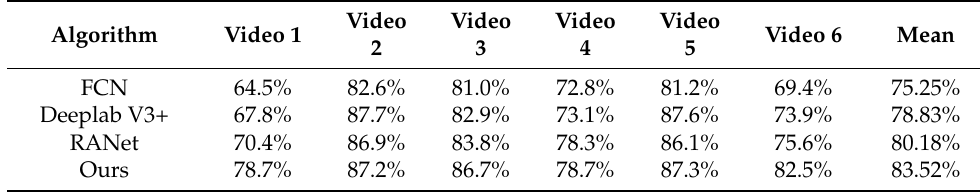
Table 3. IoU values of testing examples in Dataset